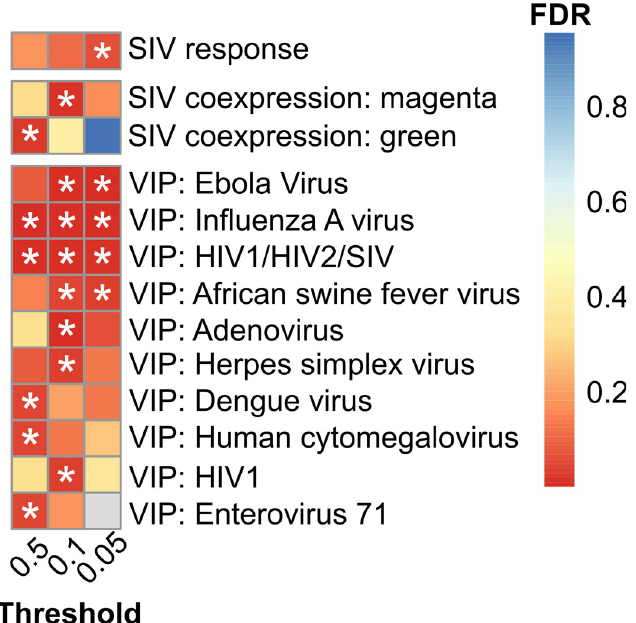
Fig 3. Enrichment of HIV/SIV-related and VIP categories in 3P-CLR candidate genes for the central-eastern ancestor. Columns for the three 3P-CLR quantiles, rows for each category that is significantly enriched in at least one quantile (FDR < 0.05). From top to bottom: SIV response genes [39,40], SIV co-expression modules [26] and VIPs [46,47].For the SIV-response gene set there is only one category, hence we consider p-value < 0.05 as significant, following [32]. Colours represent FDR values, with grey representing categories undetected in that particular quantile. Stars mark categories with FDR < 0.05.